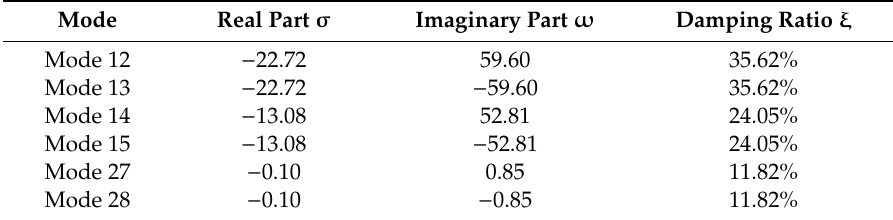
Table 8. Oscillatory modes, operating point 2, SVC connected.